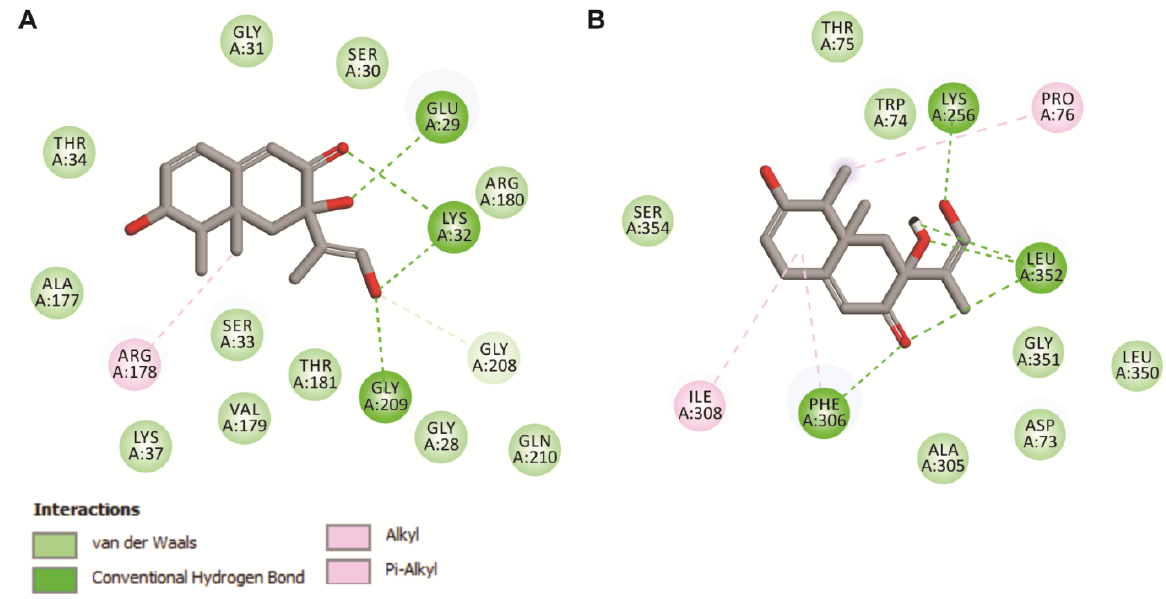
Figure 3. Intermolecular contact analyses of the top-ranked poses of Bipolaroxin with G-protein alpha ( A ) subunit and G-beta subunit of Triticum aestivum ( B ). The image was generated using BIOVIA DSV. Table 2. Molecular docking results of Bipolaroxin with G-protein alpha and beta subunit of Triticum aestivum using